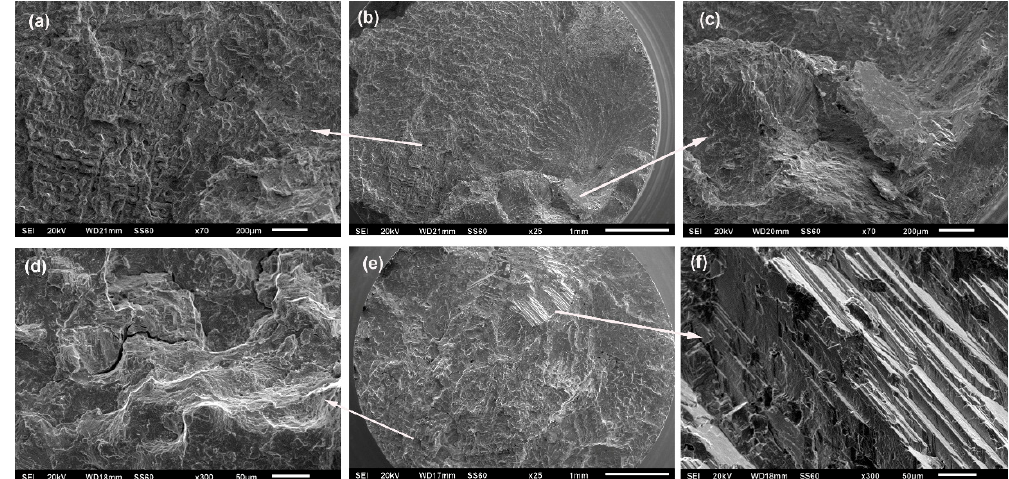
Figure 6. Fracture surfaces in alloys with 0.25 wt % B: ( a – c ) 0.25B-AC alloy after 3,738,217 cycles at 541 MPa; ( d – f ) 0.25B-HT alloy after 2,033,481 cycles at 615 MPa.